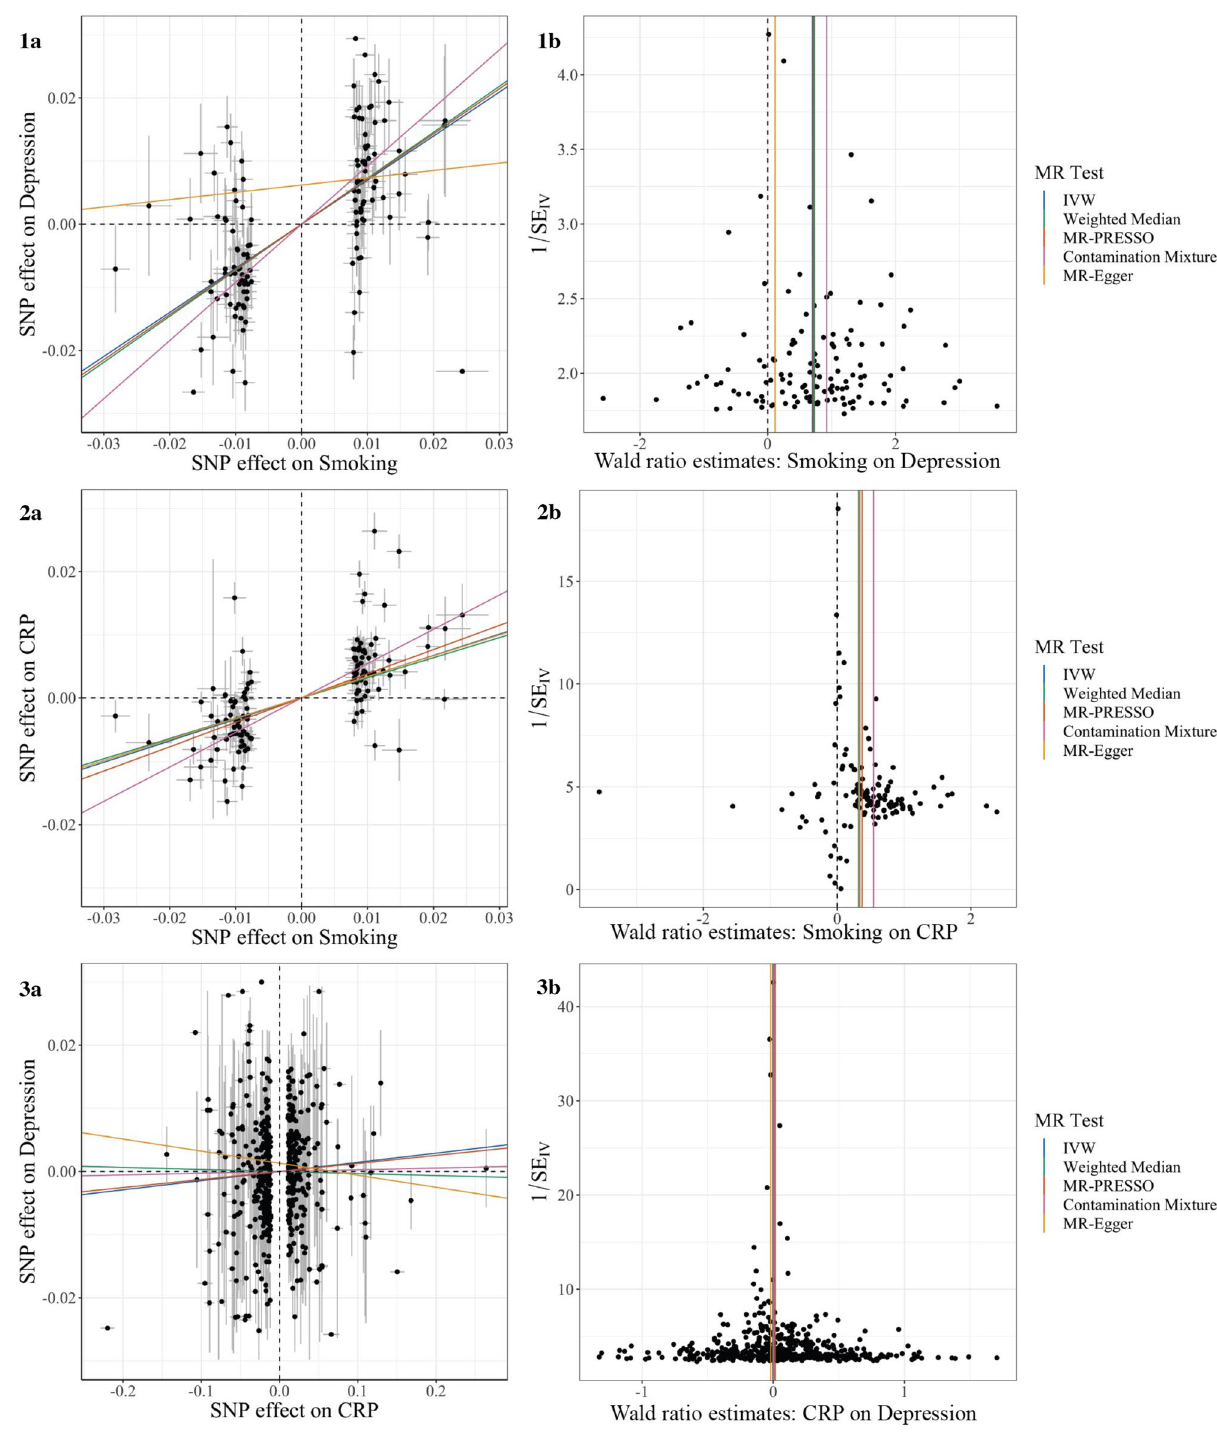
Figure 2. Main analyses: Effect of ( 1 ) smoking on depression, ( 2 ) smoking on CRP, and ( 3 ) CRP on depression. ( a ) Scatterplot showing the relationship between the variant-depression associations (x-axis) and the variant- smoking associations (y-axis) with standard error bars. The slopes of the colored lines correspond to the estimated causal effect obtained with each method used. ( b ) Funnel plot showing the relationship between the causal effect of the exposure on the outcome estimated using the Wald ratio estimate for each IV (x-axis) against the inverse of the standard error of the such estimate (y-axis). Vertical lines show the causal estimates using all SNPs combined into a single instrument for each of five different